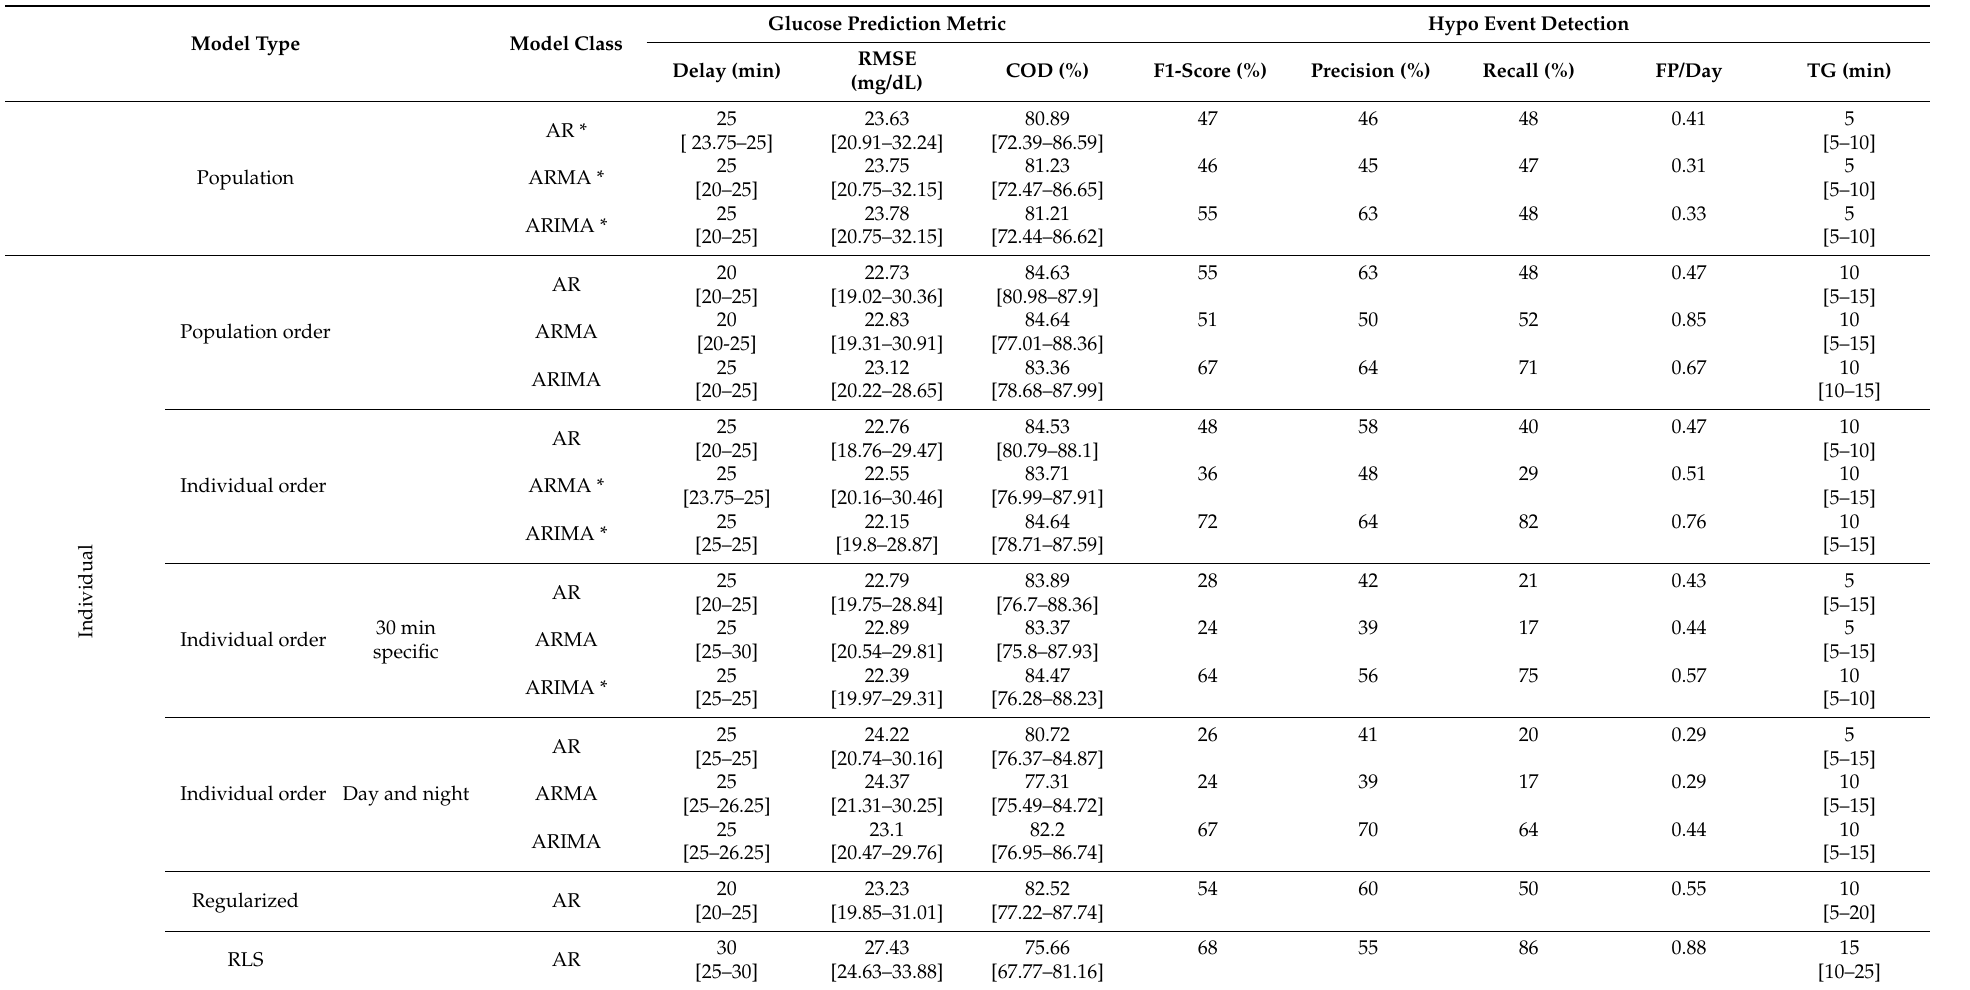
Table 2. Performance of linear algorithms with a representative dataset partitioning (30-min partition horizon (PH)). The asterisks indicate p -values <